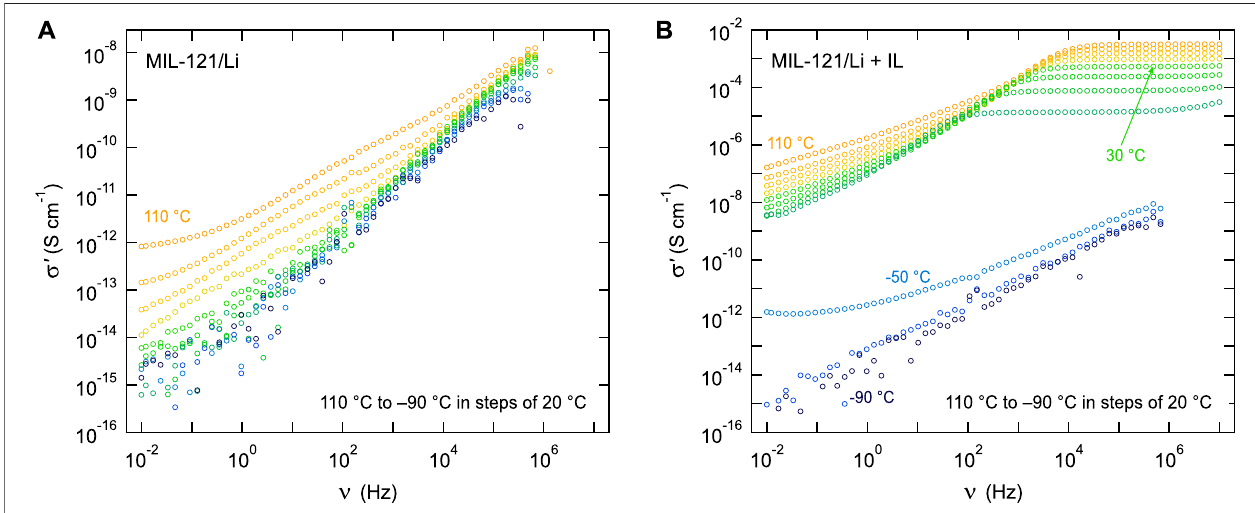
FIGURE 2 | (A) Conductivity isotherms of the lithiated MIL-121/Li sample. Approximately one third of the protons of the carboxylic groups are exchanged with Li + ions.Withoutanyionicliquid,thedryMIL-121/Libehaveslikeaninsulatorupto110 ° C,whereitshowsanextremelypoorconductivityatlowfrequencies. (B) Conductivity isotherms of the lithiated MIL-121/Li + IL showing a conductivity that is eight orders of magnitude higher than that of MIL-121/Li. This sample contains 23 wt% EMIM- TFSI ionic liquid and 77 wt% MIL-121/Li.